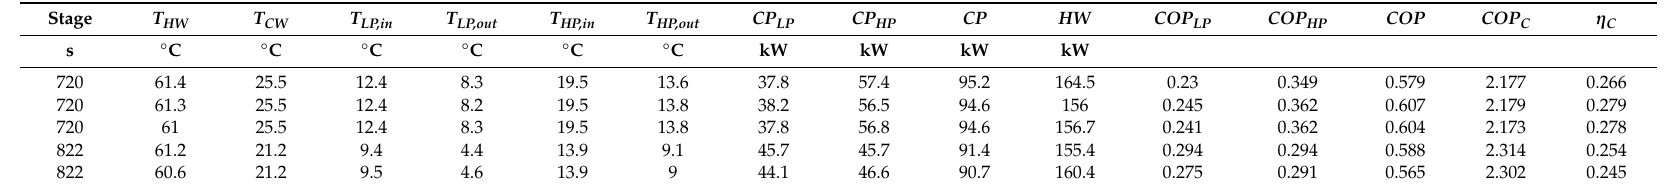
Table 7. Results of 5 measurements with the highest cooling power (new control